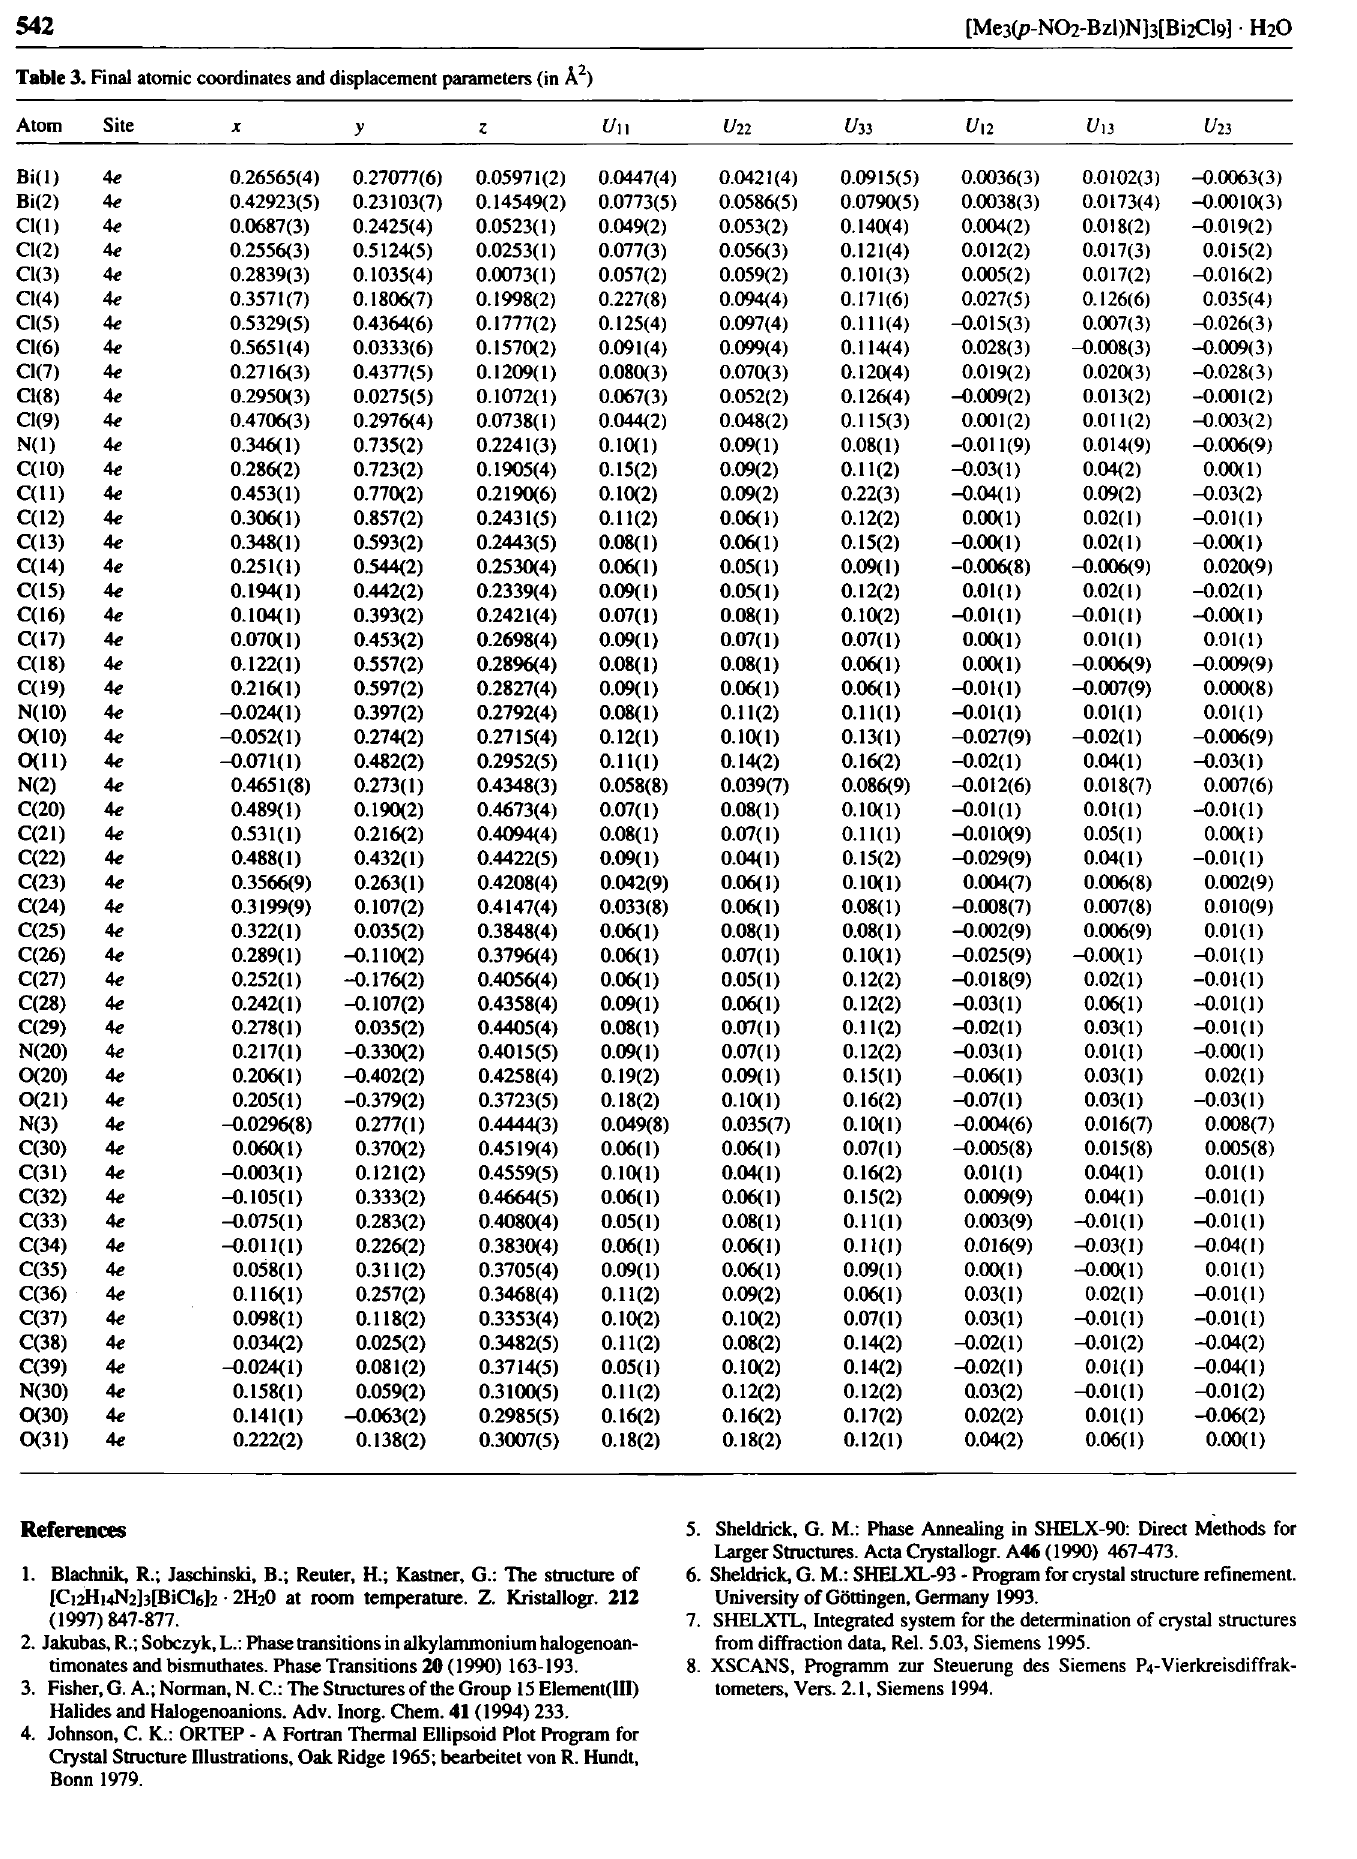
Table 3. Final atomic coordinates and displacement parameters (in Â^)